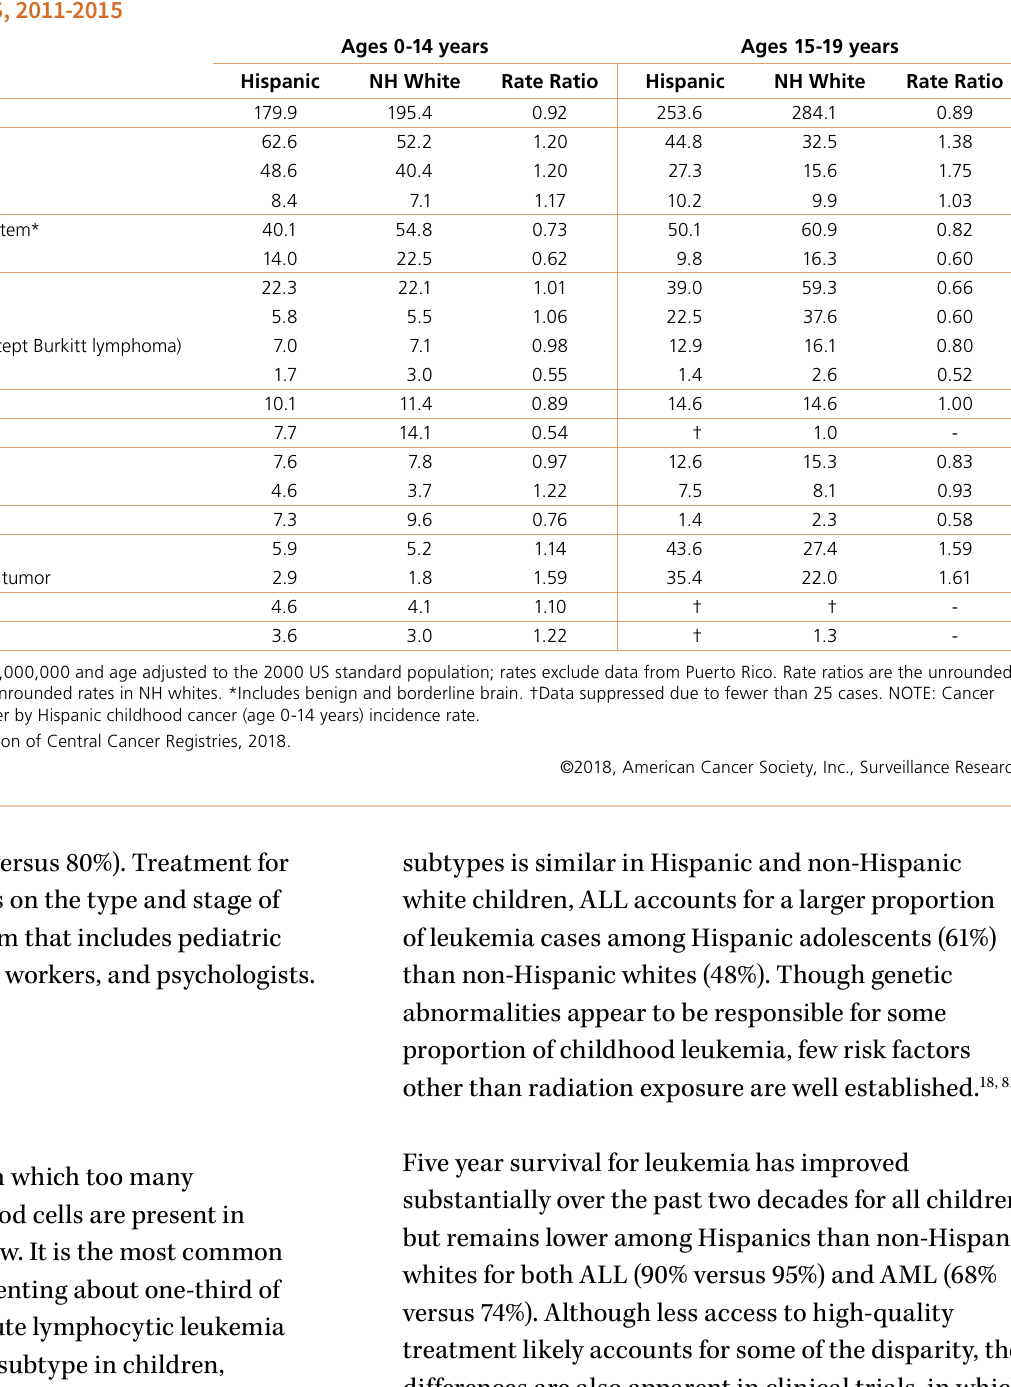
Table 5. Childhood and Adolescent Cancer Incidence Rates and Rate Ratios Comparing Hispanics to Non-Hispanic Whites, US,